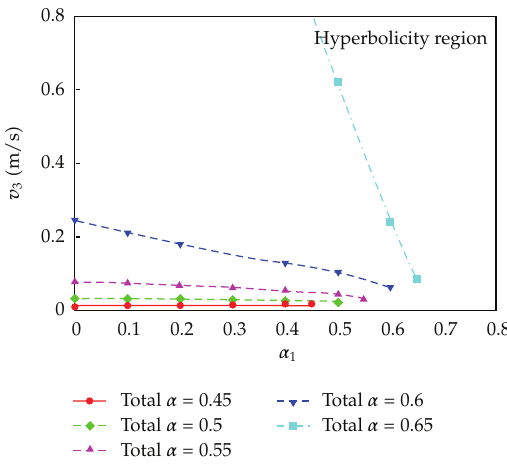
Figure 10: Stability criteria of the one-dimensional two-fluid-IATE model with momentum flux parame-